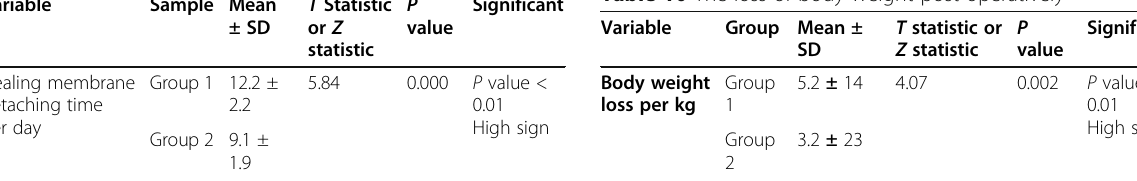
Table 10 The loss of body weight